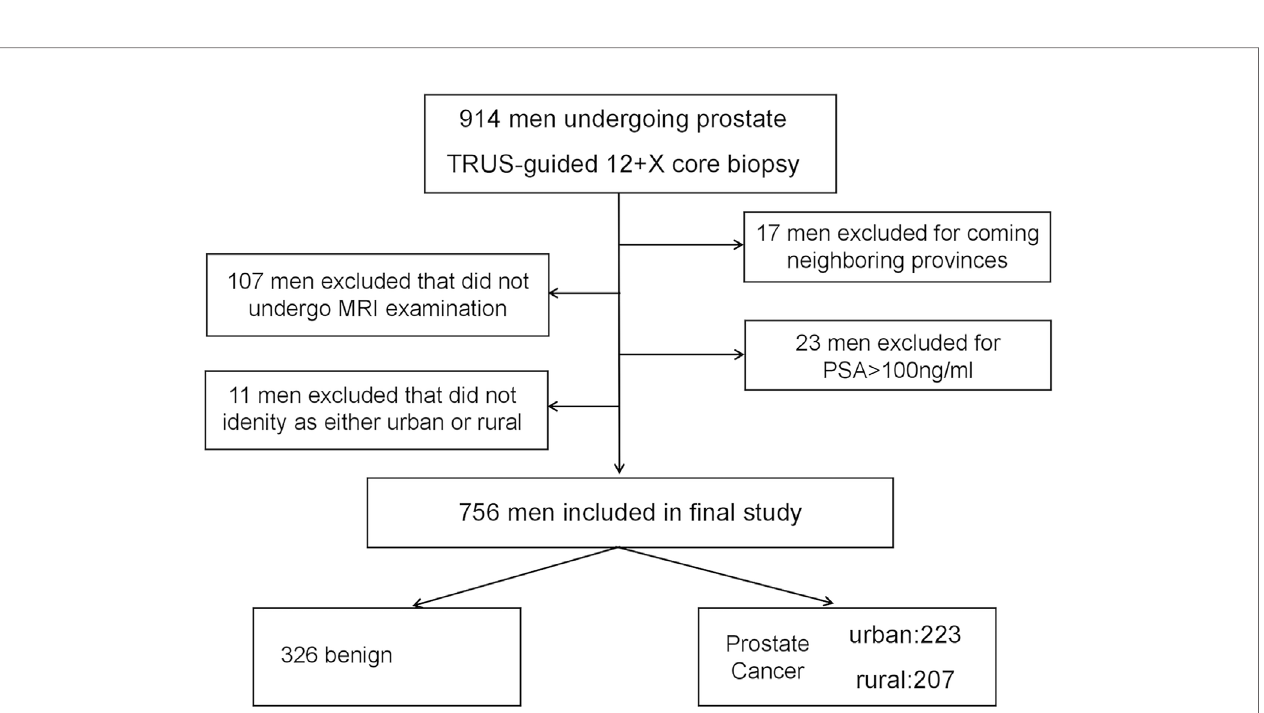
FIGURE 2 | Flow chart schematic of study recruitment and retention.